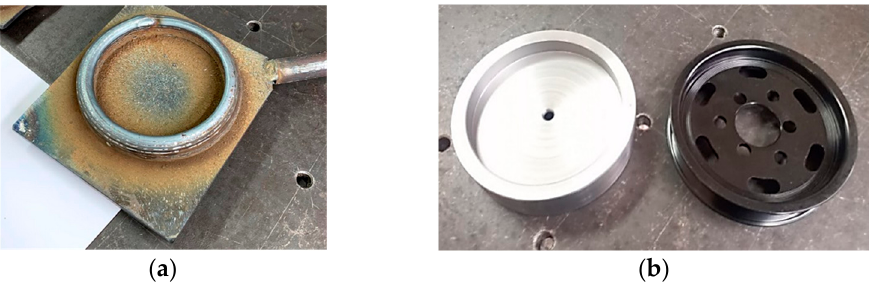
Figure 2. Exploratory study—automotive component using the WAAM—of first trials to obtain finished products with this process, prior ( a ), post-finishing ( b ).